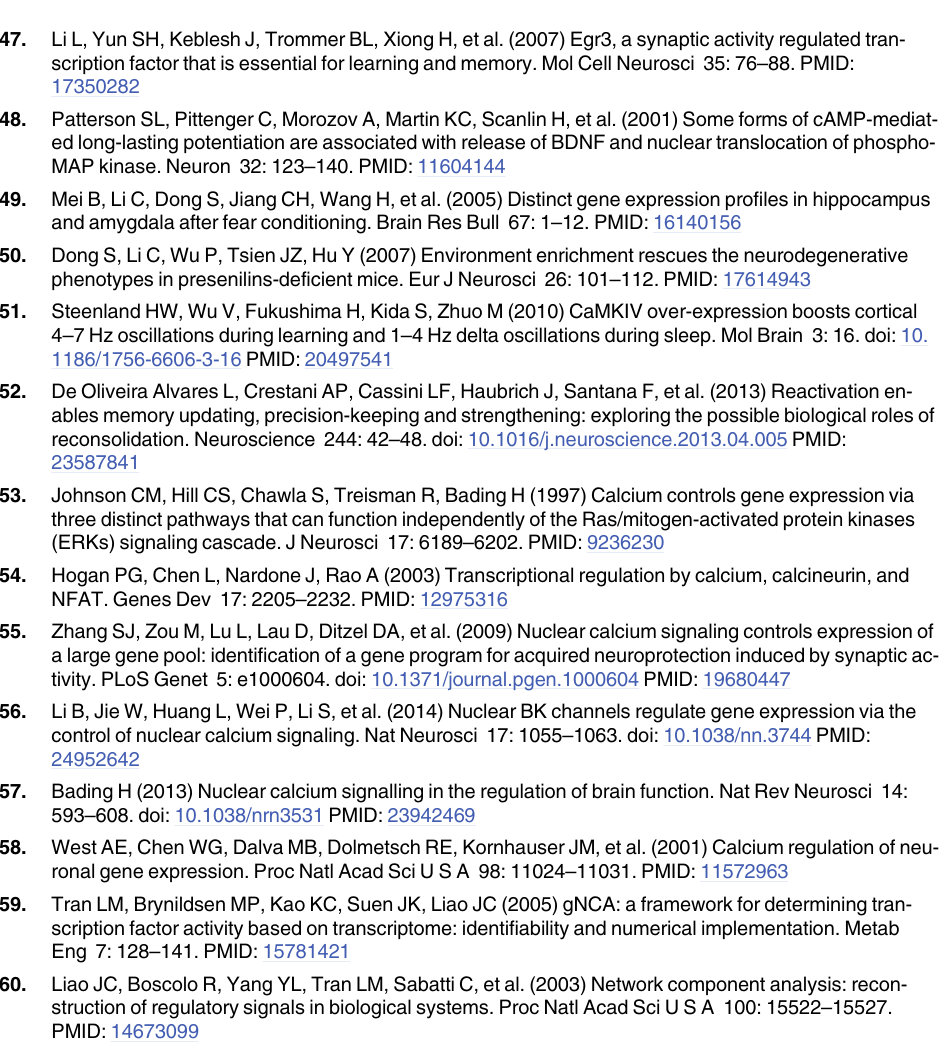
PLOS ONE | DOI:10.1371/journal.pone.0118832 March 13,